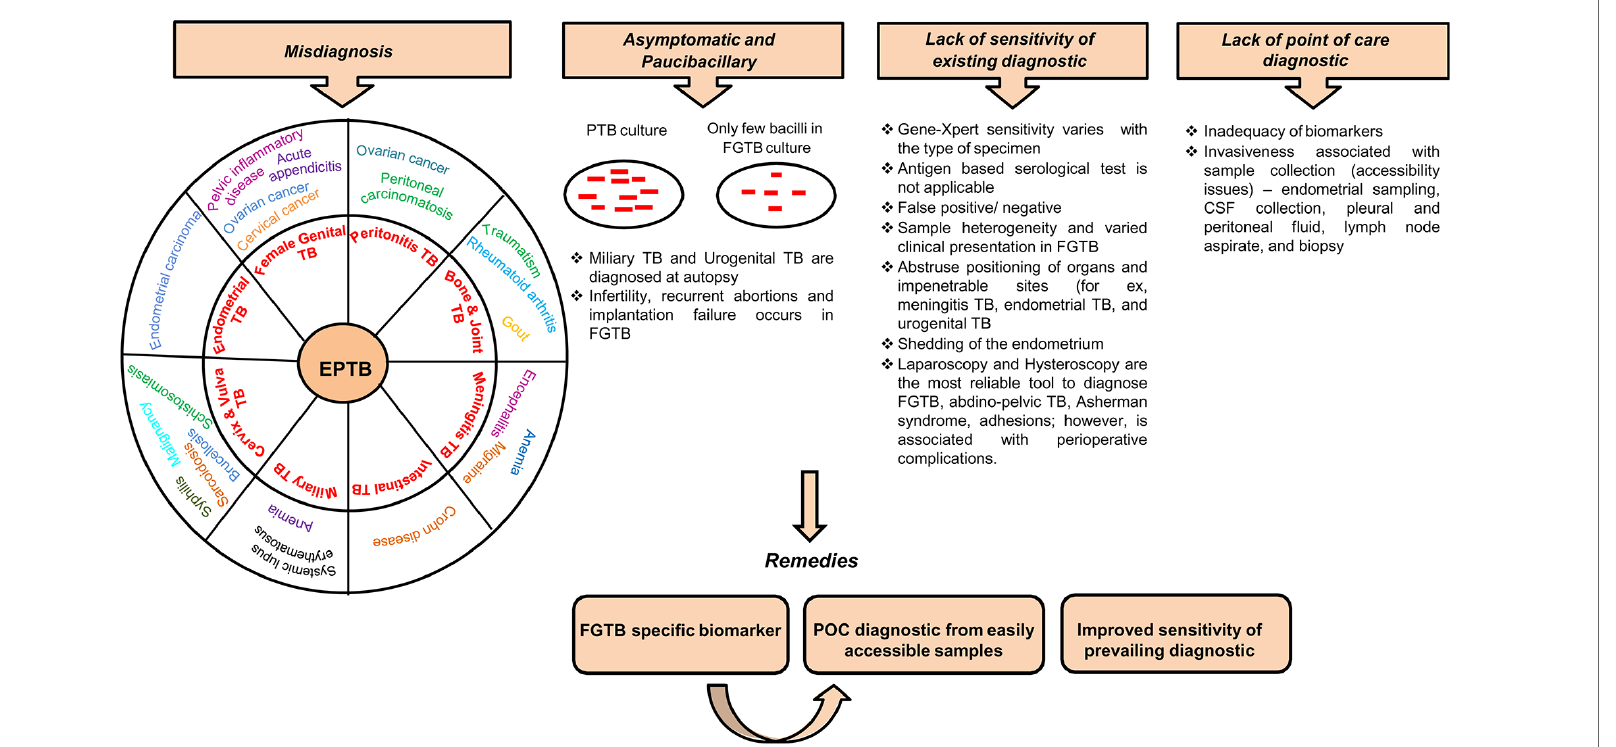
FIGURE 1 | Diagnostic challenges and remedies for EPTB, in particular FGTB. Various challenges associated with EPTB diagnosis, such as misdiagnosis, often asymptomatic and paucibacillary nature of bacilli, lack of sensitivity of existing conventional methods, and lack of point-of-care diagnostics, lead to loss due to